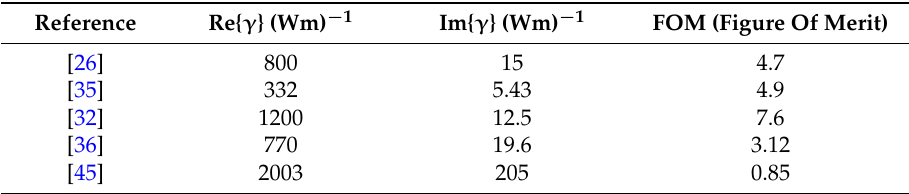
Table 2. a-Si materials reported in the